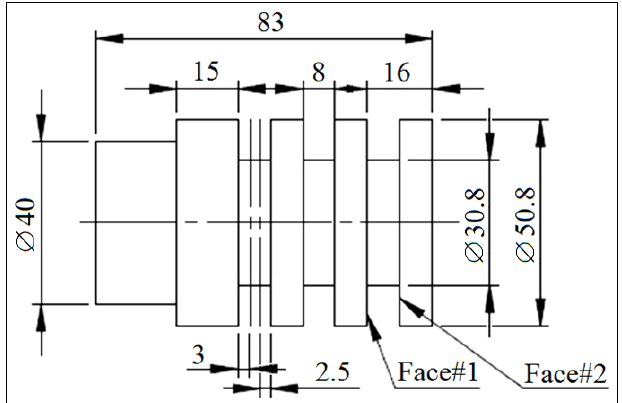
Figure 2: Workpiece geometry and dimensions (mm).